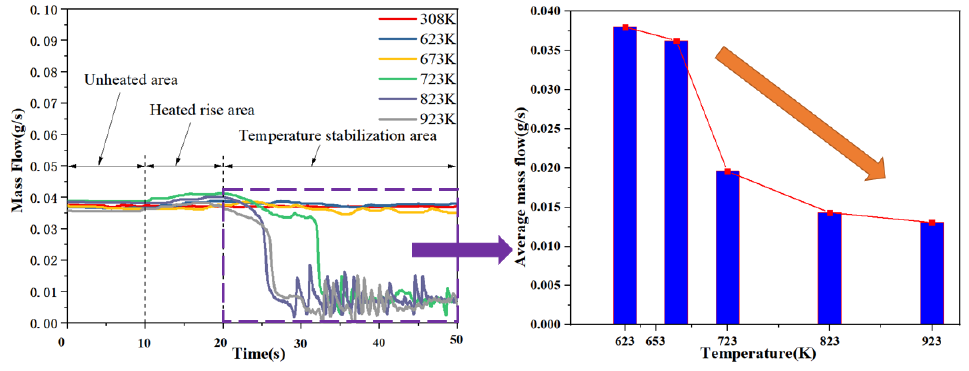
Figure 6. Flow rate change curve in capillaries.